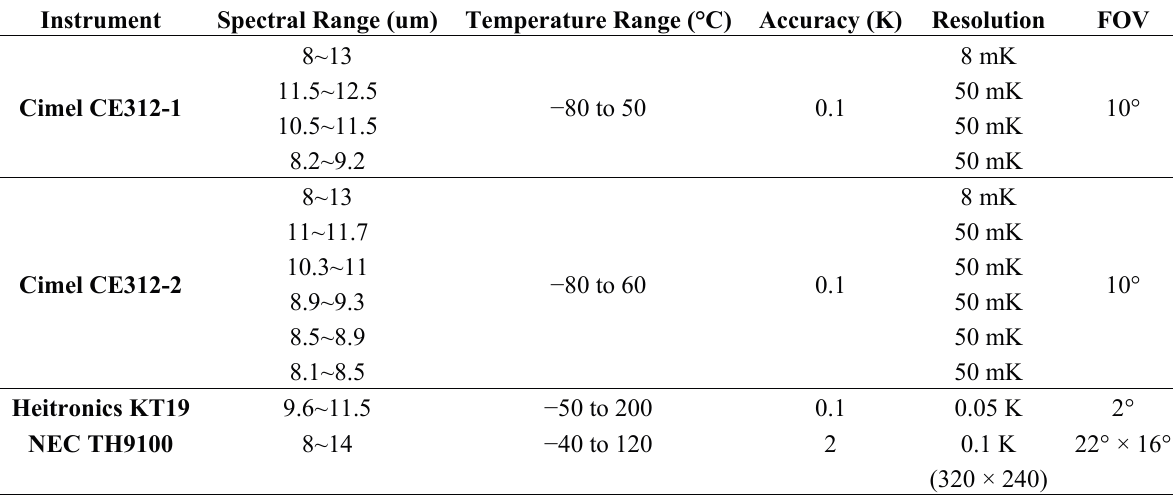
Table 3. Technical specifications of the thermal instruments